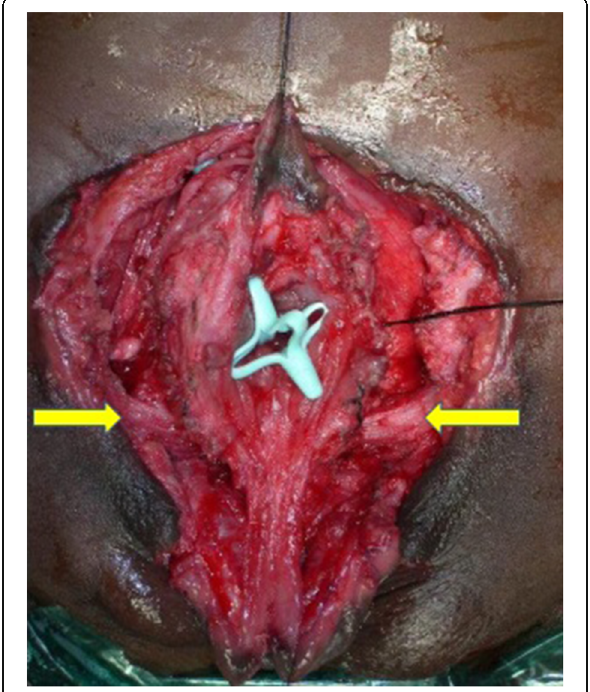
Fig. 1 Intraoperative photograph showing the dissected Intersymphyseal bands (yellow